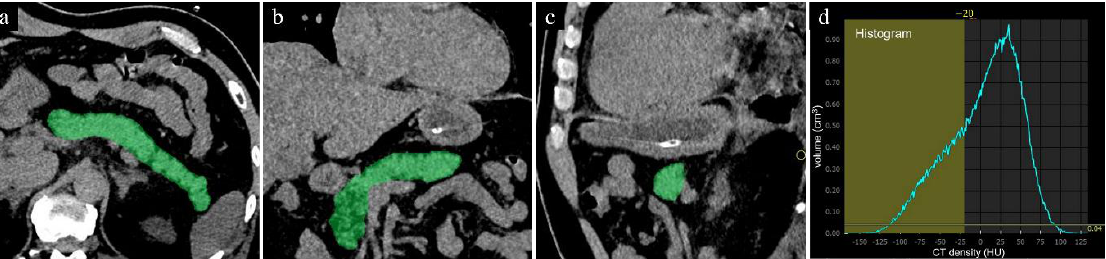
Figure 2. The measurement of the pancreatic fat volume on unenhanced CT. ( a ) axial, ( b ) coronal, ( c ) sagittal CT images. The pancreatic whole volume was measured in cm 3 on unenhanced CT images using all slices, using an automated segmentation program installed in the workstation. ( d ) The pancreatic fat volume within the pancreas was calculated by means of a histogram analysis with local thresholding.